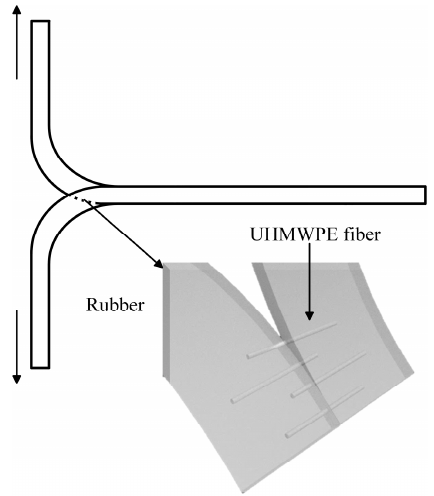
Figure 3. Schematic diagram of the mechanism for improving the tearing strength of